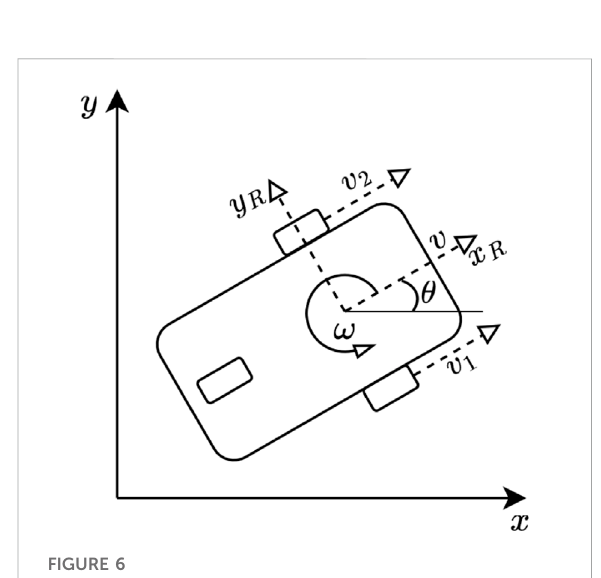
FIGURE 6 Differential-drive mobile robot kinematic